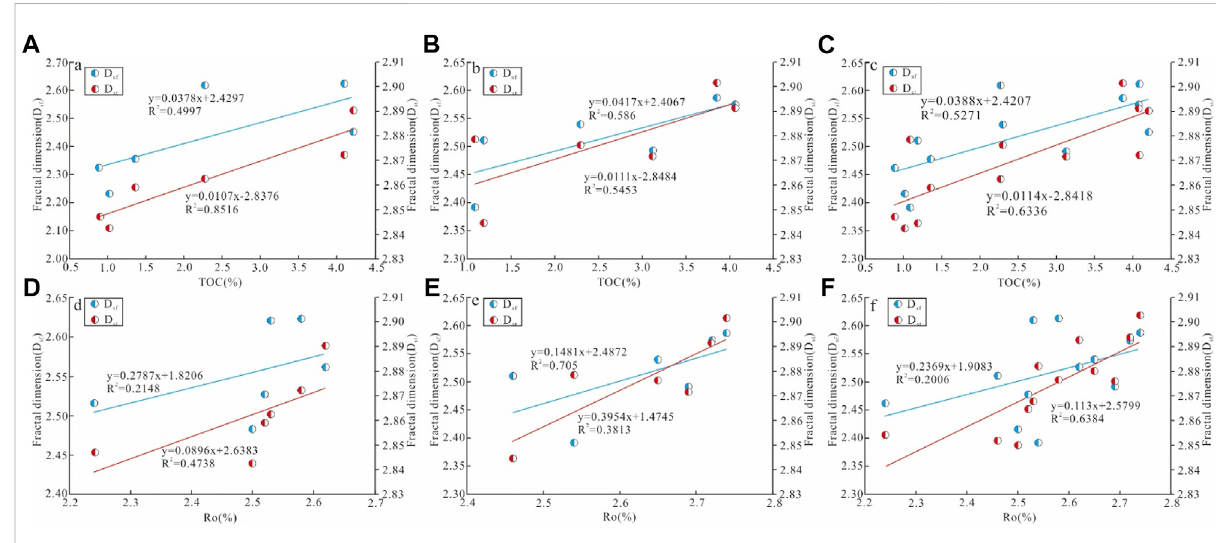
FIGURE 6 Correlation between the organic matter content and maturity and fractal dimension of the